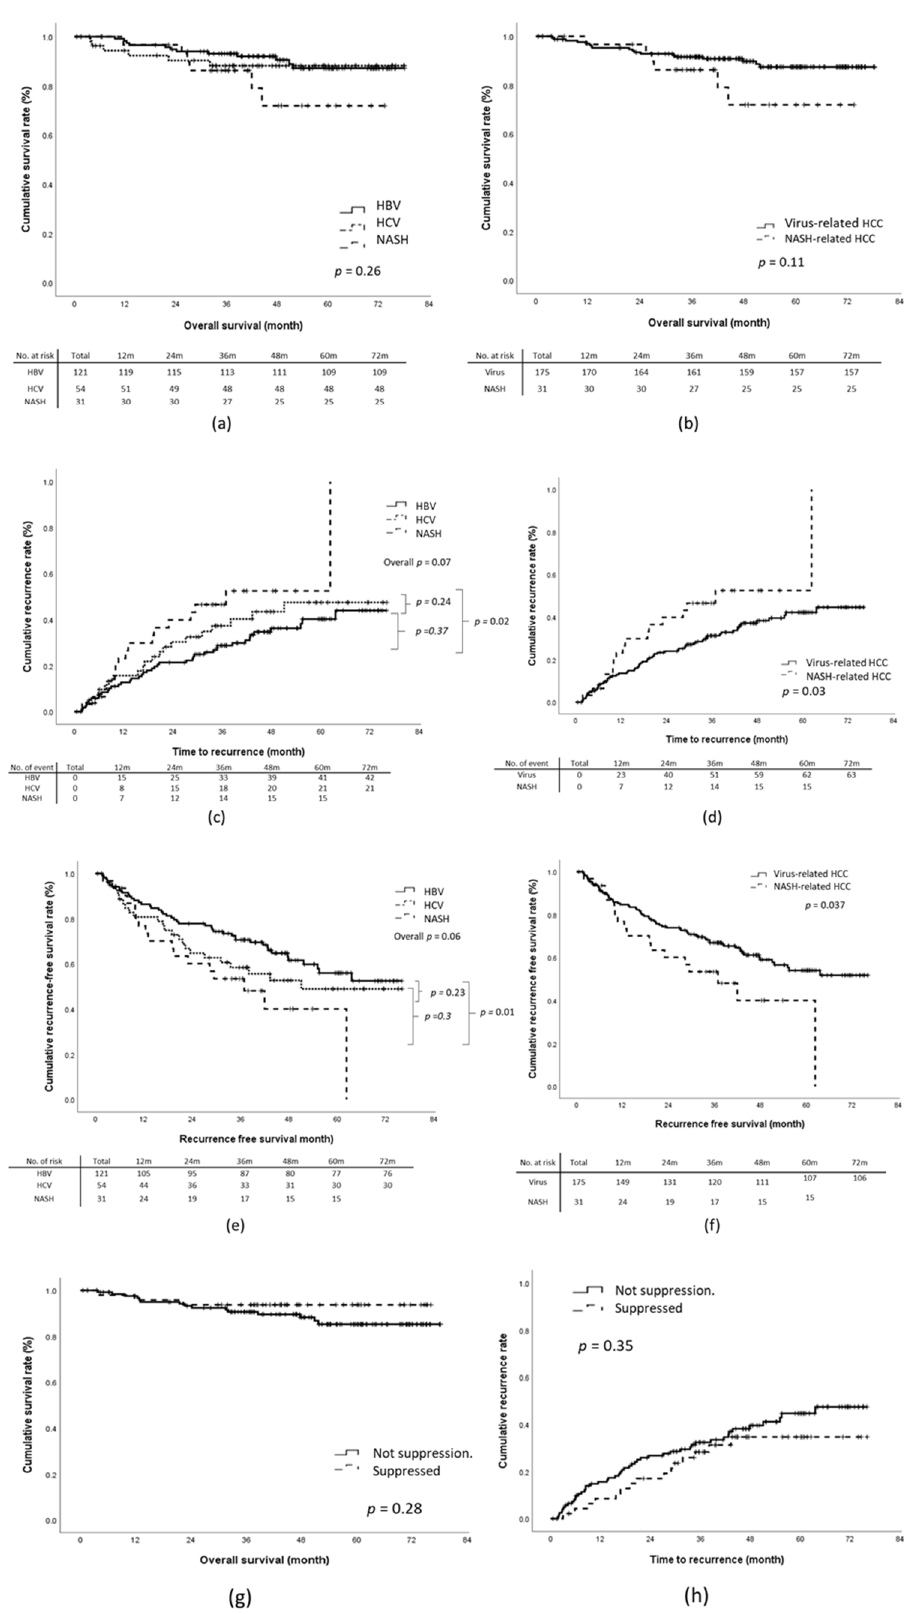
Figure 2. Outcomes according to etiology of liver disease: ( a , b ) overall survival (OS), ( c , d ) time-to- recurrence (TTR), ( e , f ) recurrence-free survival (RFS). ( g , h ): OS and TTR according to viral suppression status.